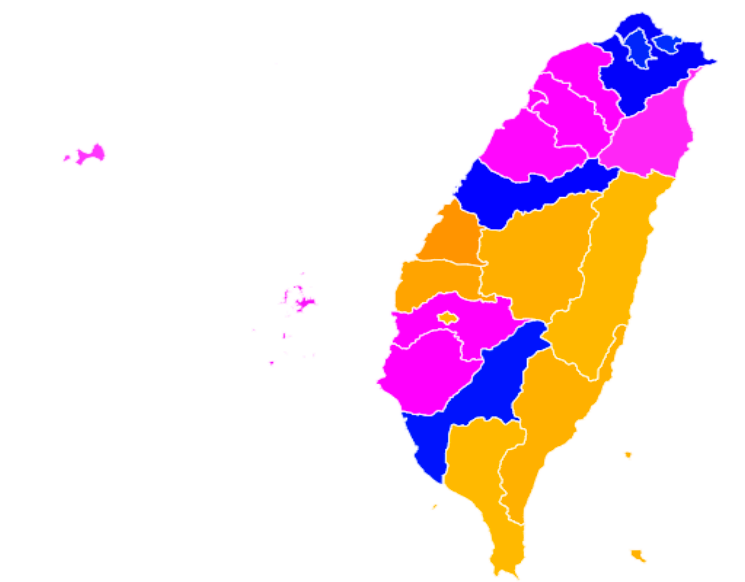
Figure 2. Map of age friendly city clusters in Taiwan (Note: Blue: Infrastructural, Pink: Tranquil, Orange: Insecure).